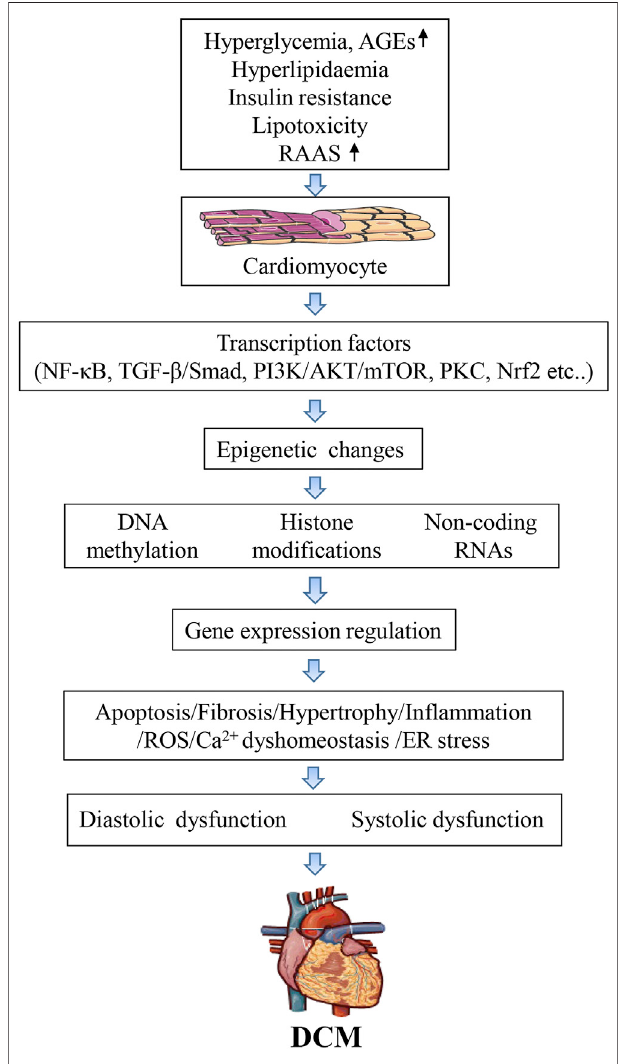
FIGURE 1 | Mechanisms of epigenetic on diabetic cardiomyopathy.